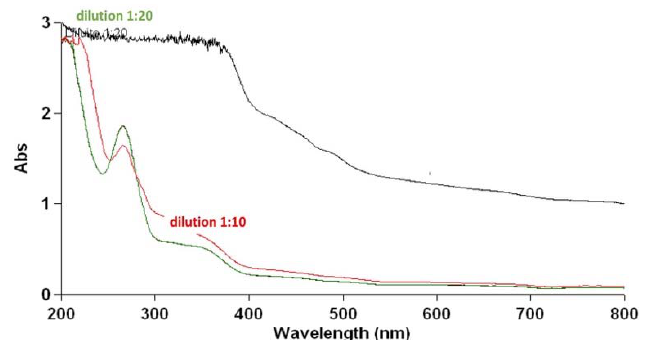
Figure 11. UV/VIS spectrum of a sample of the extract at different dilutions in water. The wavelength expressed in nm is shown on the abscissa axis while the absorbance is shown on the ordinate axis. The sample at a concentration equal to 50 mg/mL, with supersaturation in Abs, is shown in black. In red, is the 1:10 dilution of the starting sample, and in green, is the 1:20 dilution, the black line was the not diluted sample. In both dilutions, the spectrum reported the presence of three peaks at the wavelengths of 350 nm, 260 nm, and 190 nm. The analysis was conducted with Variant 50 Scan. The UV/VIS spectra were used to monitor the stability of the extract during the time.